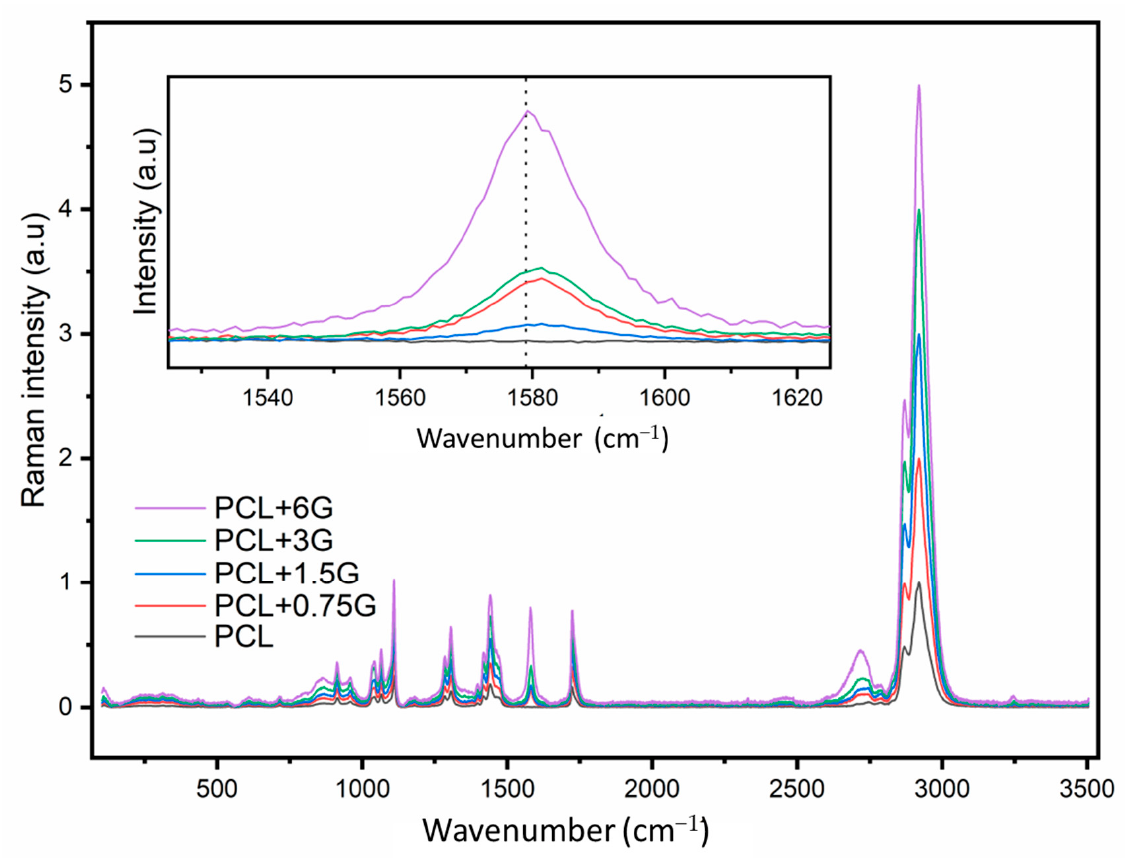
Figure 2. Raman spectra from one random location on the upper surface of 3D-fabricated scaffolds: main image represents PCL, PCL+0.75G, PCL+1.5G, PCL+3G, and PCL+6G (see colour key), and inserted image with zoomed-in region (1525–1625 cm − 1 ) demonstrates the varying Raman intensity at 1577 cm − 1 for PCL, PCL+0.75G, PCL+1.5G, PCL+3G, and PCL+6G (see colour key). Three random locations on the upper surface of each scaffold type were analysed in triplicate using a 532 nm laser at 10% power (5 mW) and focused through a x20 objective over an extended wavenumber scan, 100–3500 cm − 1 , with 10 s integration time. Averaged spectra were data-processed by cosmic ray removal, if applicable, and baseline subtraction. The x-axis is Wavenumber in cm − 1 , and the y-axis is Raman intensity in arbitrary units (a.u).